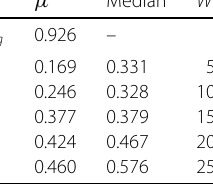
μ Median W ρ g 0.926 – ρ l 0.169 0.331 5 0.246 0.328 10 0.377 0.379 15 0.424 0.467 20 0.460 0.576